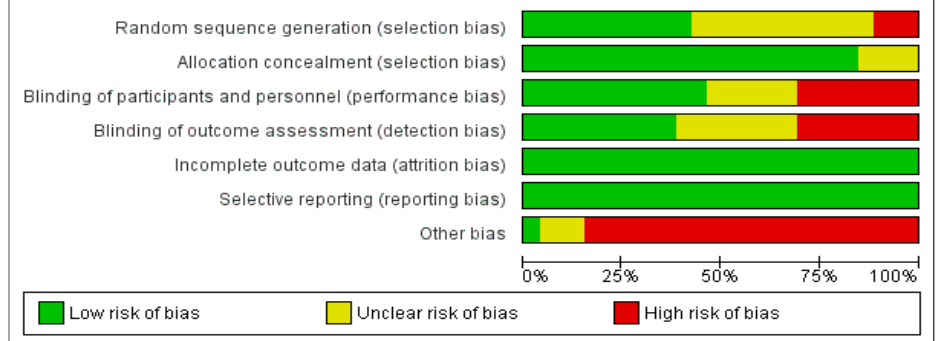
Figure 3. Risk of bias summary: review authors’ judgments about each risk of bias item for each included study.